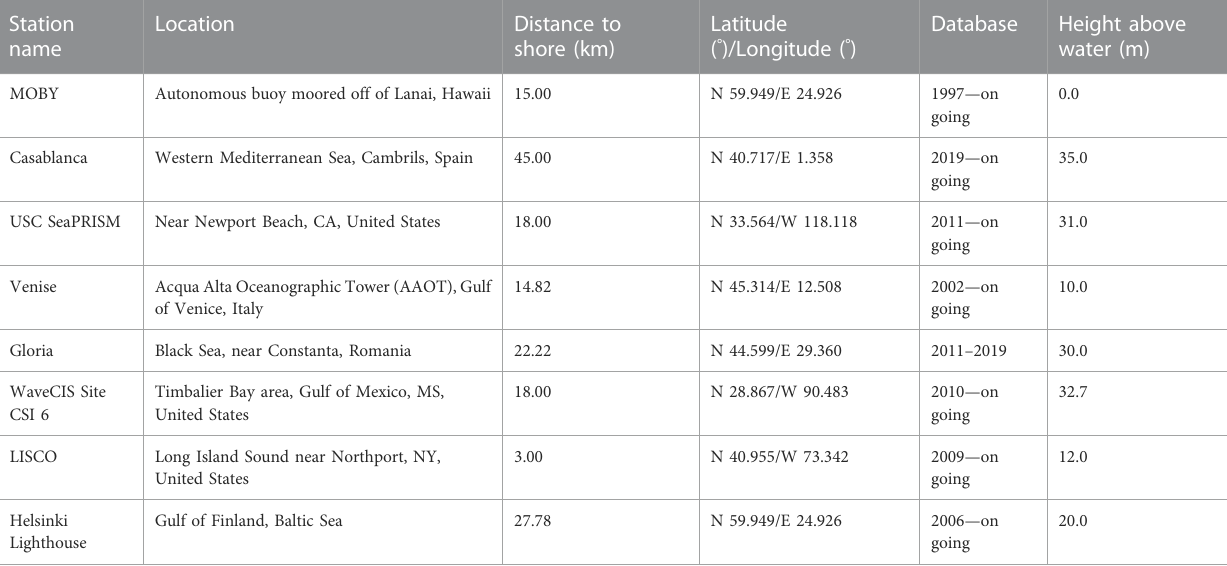
TABLE 1 Location and parameters of AERONET-OC